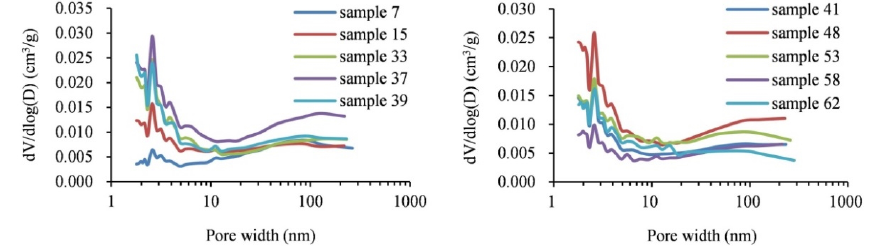
Figure 5. Pore width distribution of samples.